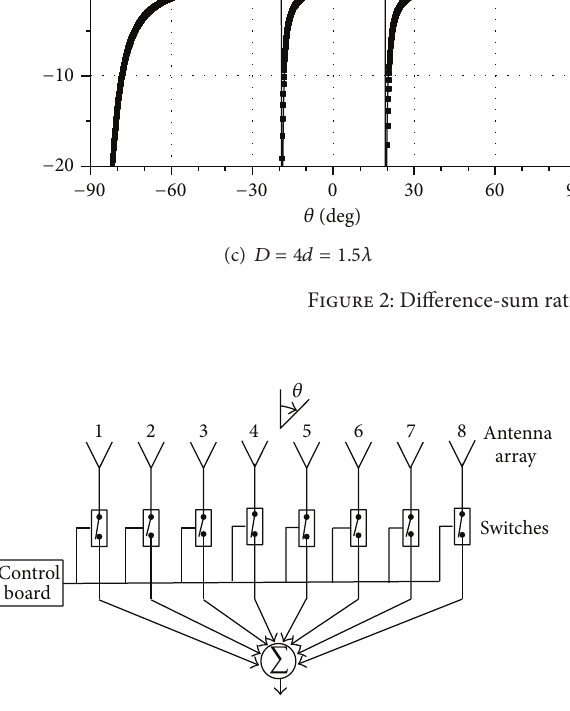
Figure 3: Block diagram of an 8-element 4D antenna